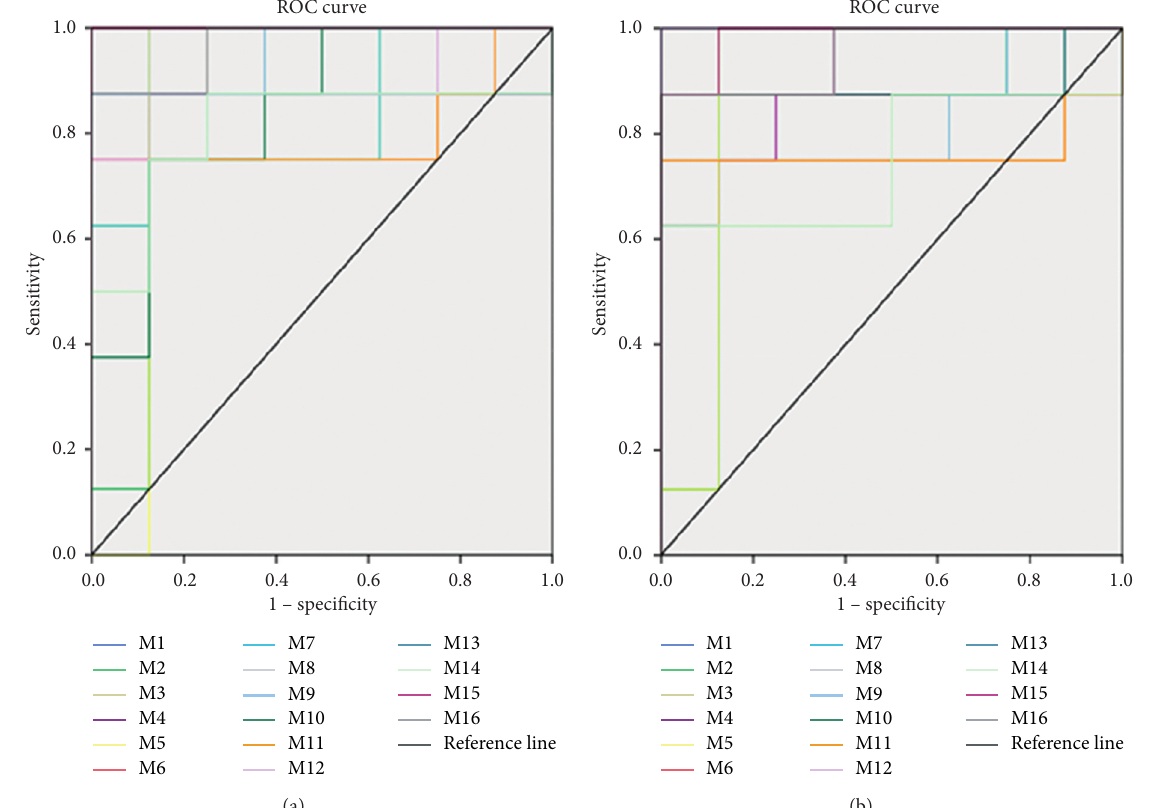
Figure 3: ROC analysis of rat important potential biomarkers: (a)1h group and (b) 24h group metabolites.